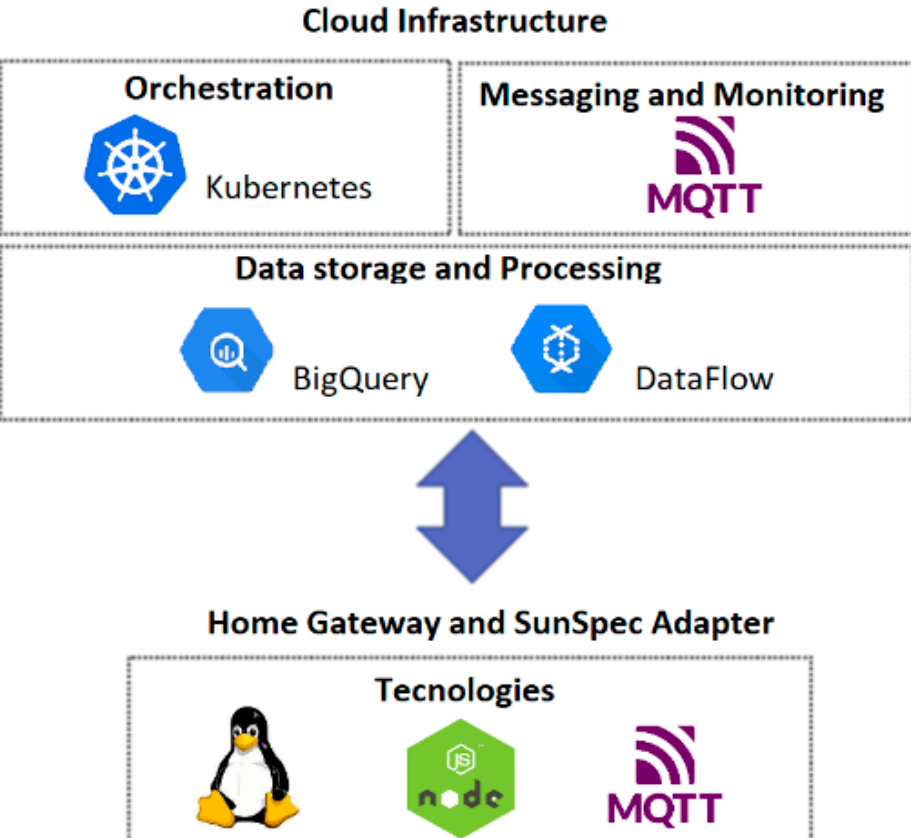
Figure 3. The proposed IoT solution as a combination of a cloud infrastructure and a home gateway.